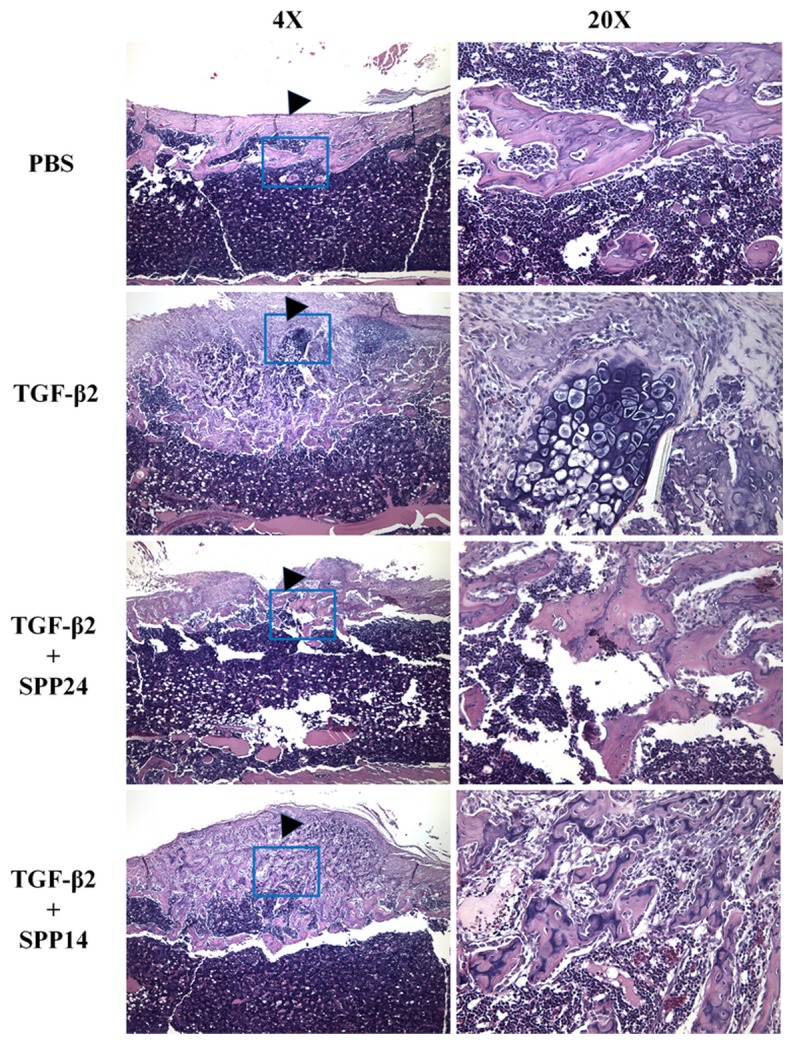
Histologic examination of representative samples from each experimental groups.Stained with H&E.